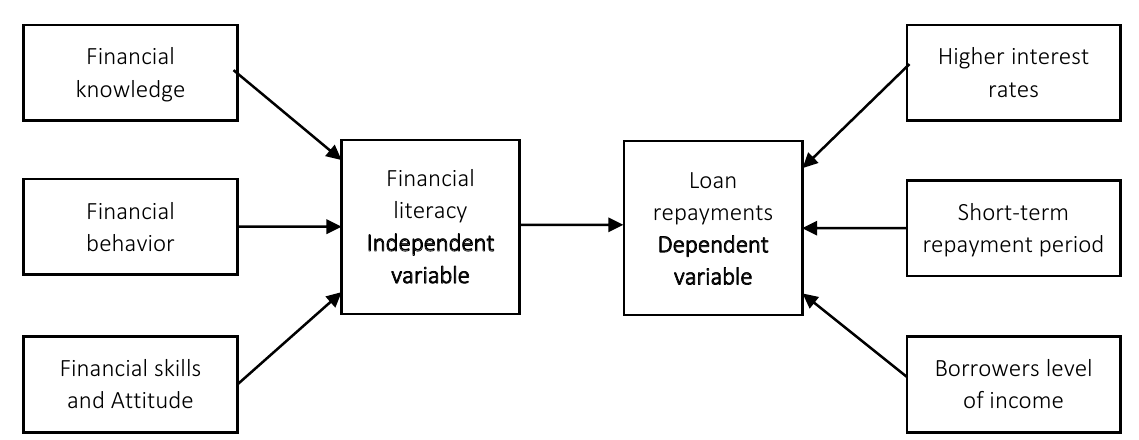
Figure 1. Conceptual